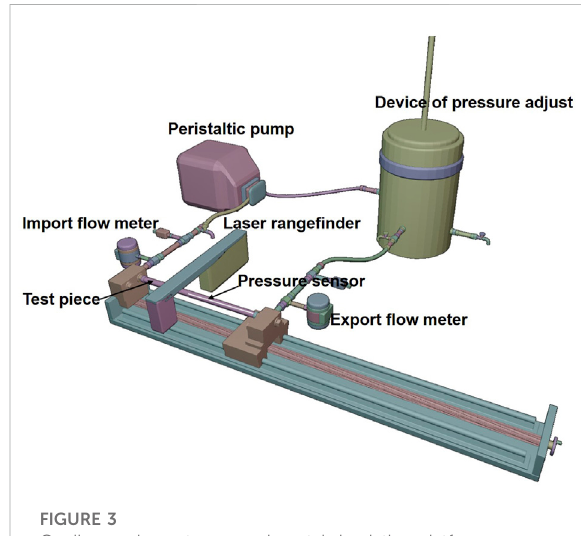
FIGURE 3 Cardiovascular system experimental simulation platform.